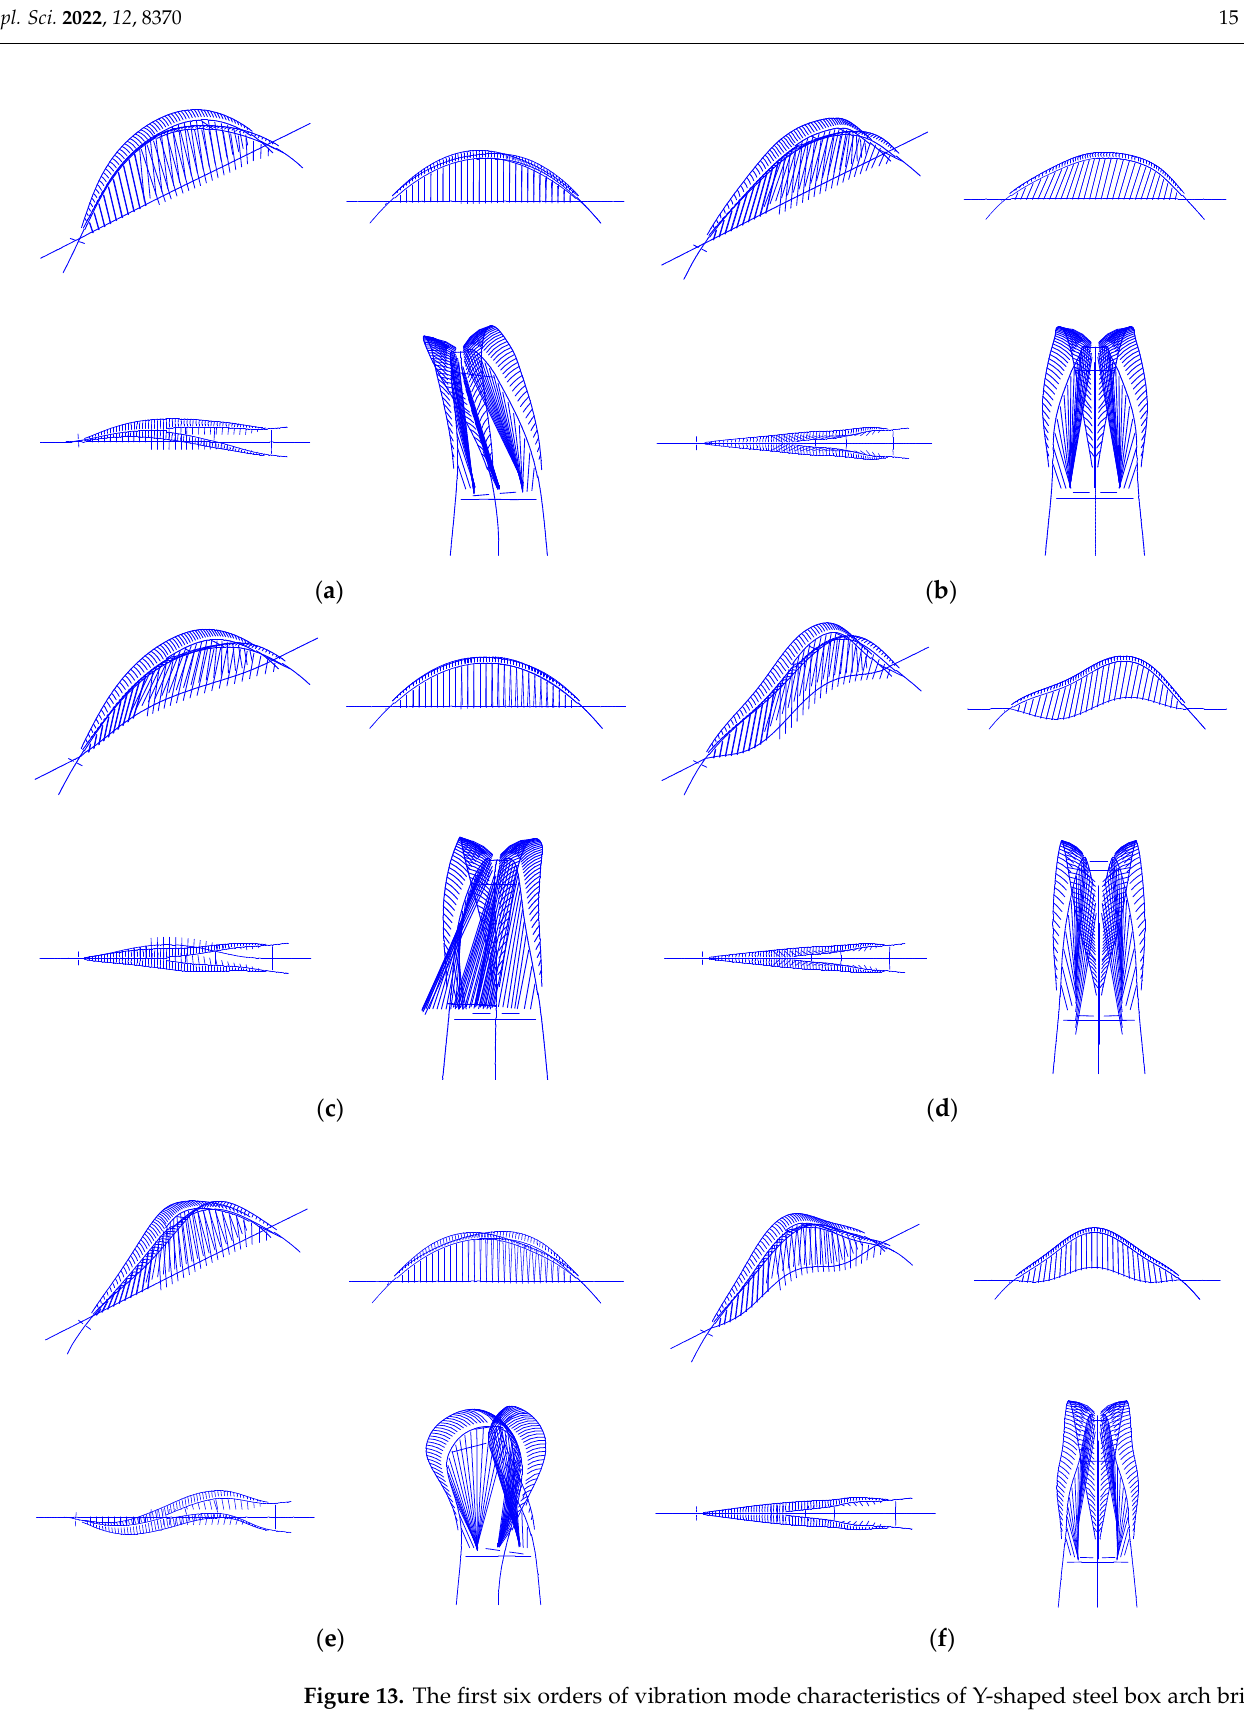
( a ) Mode 1; ( b ) Mode 2; ( c ) Mode 3; ( d ) Mode 4; ( e ) Mode 5; ( f ) Mode 6.